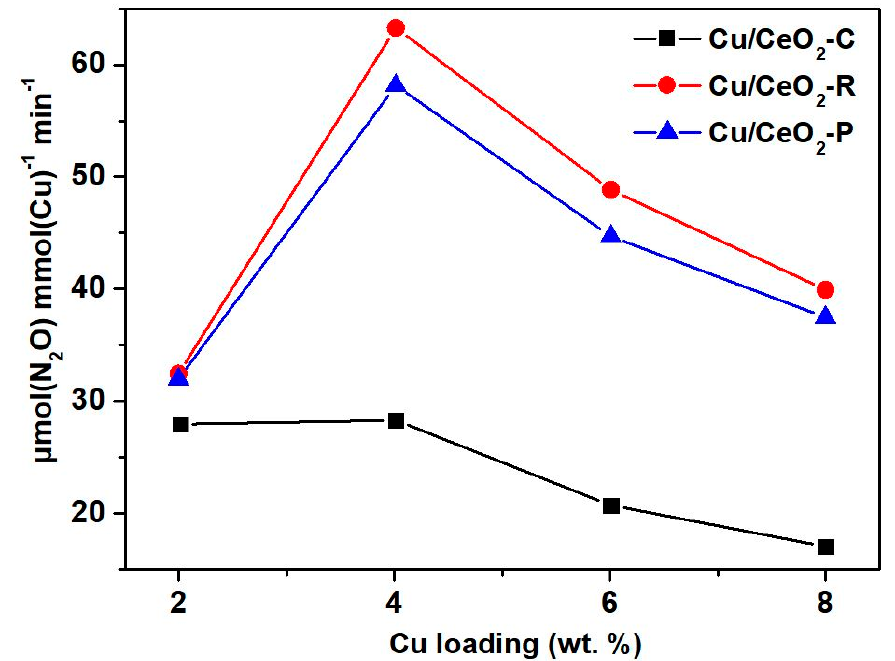
Figure 15. The activity of nanoshaped CuO x /CeO 2 catalysts measured at T = 375 °C. Adapted from Reference [146]. Copyright© 2015, American Chemical Society.